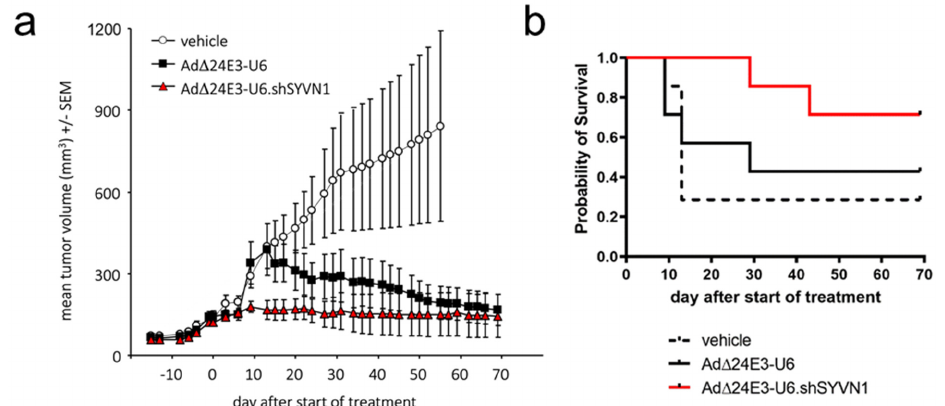
Figure 6. Antitumor activity of Ad Δ 24E3-U6 and Ad Δ 24E3-U6.shSYVN1 in subcutaneous A549 xenograft tumors in vivo. Mice bearing established A549 tumors were injected for 4 consecutive days with Ad Δ 24E3-U6 or Ad Δ 24E3-U6.shSYVN1 at a dose of 2.5 × 10 8 IU or with vehicle. ( a ) Tumor sizes were measured for two months or until mice were sacrificed when tumors grew larger than 2000